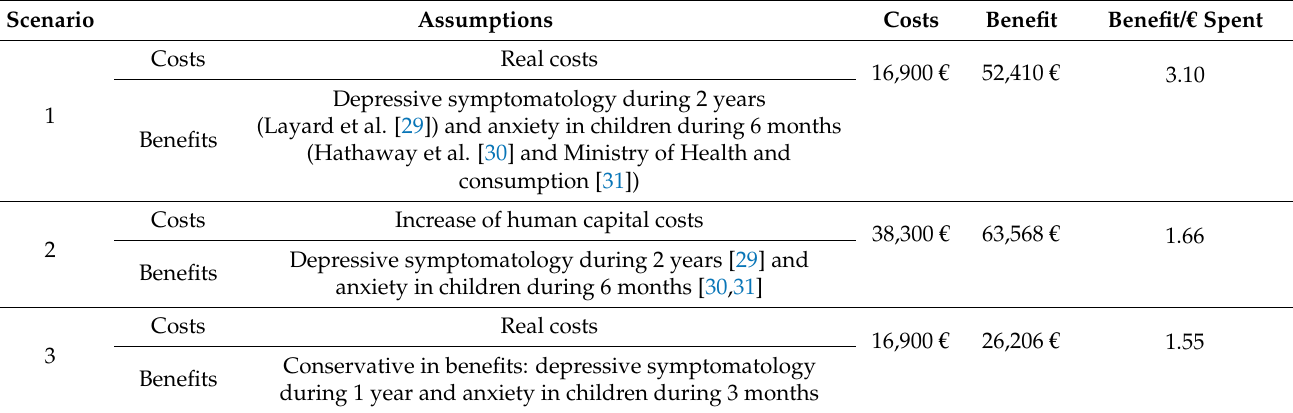
Table 8. Summary of results in three different scenarios (for every 100